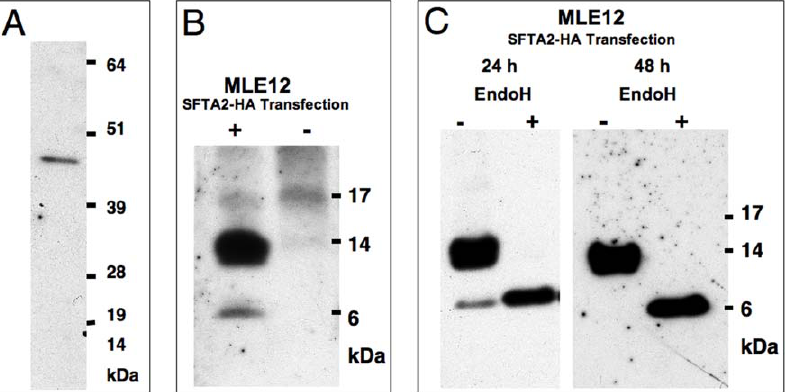
Figure 4. Immunoblot analysis and N-glycosylation testing of human SFTA2 . A. Anti-human SFTA2 peptide antibodies detect 50 ng of SFTA2-MBP fusion protein with an expected molecular weight of 48.5 kDa. B. 24 hrs after transfection with pCDNA3-SFTA2-HA, specific bands are detected at the expected 6.5 kDa, but also at 13 kDa ( + transfected, - non-transfected MLE12 cells). C. MLE12 cells were harvested 24 h (left) or 48 h (right) after transfection. While after 24 hrs the 6 kDa band is still present, it has disappeared after 48 h. Deglycosylation using endo- b -N- acetylglucosaminidase shifts the 13 kDa band to 6 kDa demonstrating that the 13 kDa band represents a N-glycosylated form.